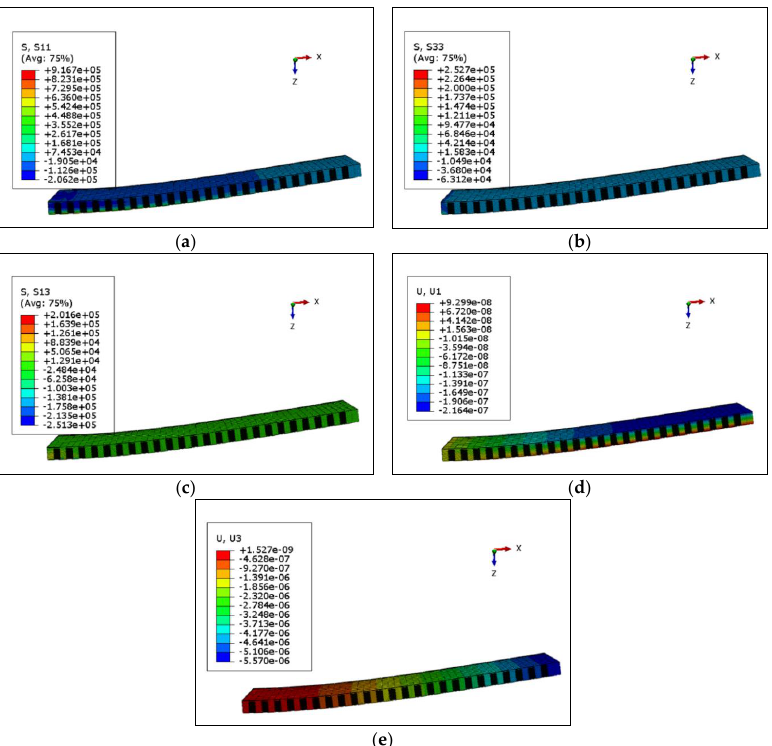
Figure 5. Cloud diagram of stress and displacement for the case α 1 = − 2, α 2 = − 3: ( a ) σ x ; ( b ) σ z ; ( c ) τ xz ; ( d ) u ; ( e ) w .